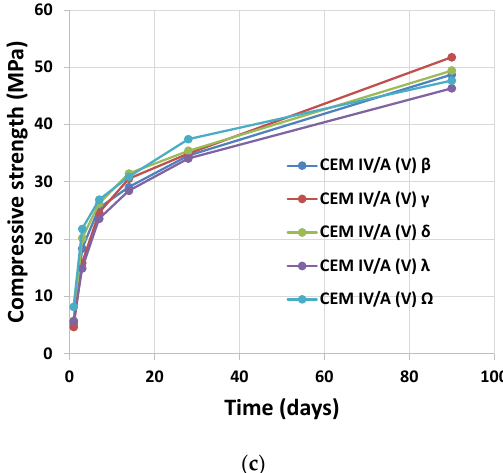
Figure 8. Compressive strength of mortars from one to 90 days: ( a ) CEM I and CEM II/A-V mortars; ( b ) CEM II/B-V mortars; and ( c ) CEM IV/A (V) mortars.